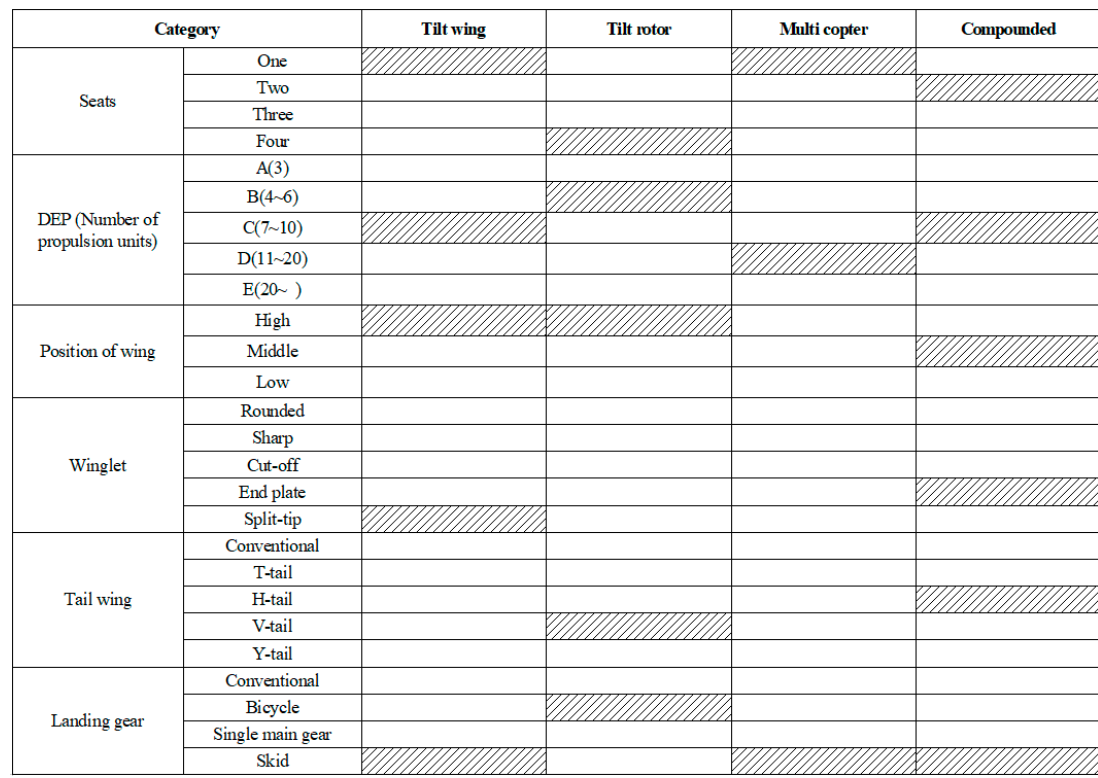
Figure 9. Configuration tradeoff study matrix.